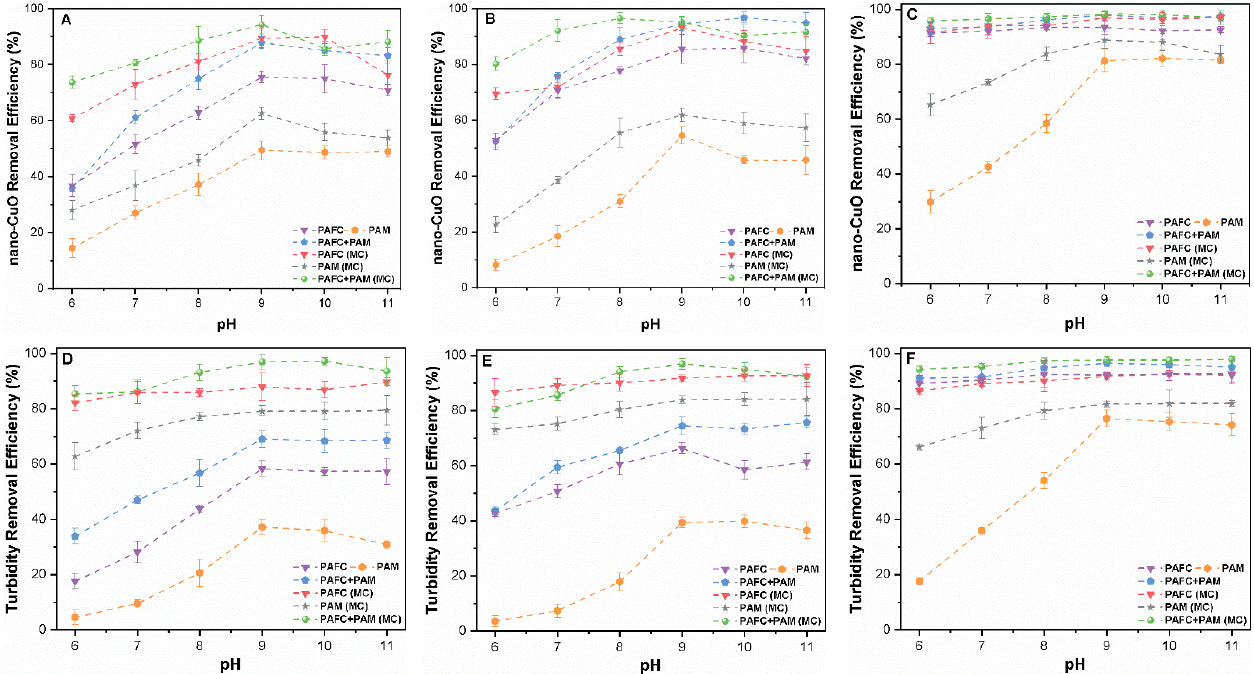
Figure 2. Influence of pH (6–11) on the removal efficiency of nano-CuO and turbidity for various mass concentrations ( A , D ) 1 mg/L, ( B , E ) 2.5 mg/L and ( C , F ) 10 mg/L.